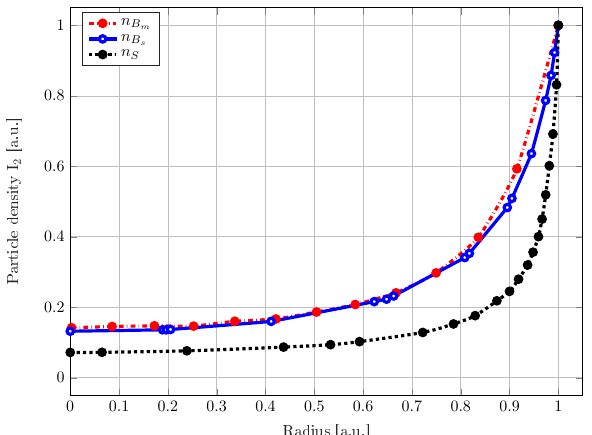
Figure 4. I 2 -particle density distribution along the lamp radius in the middle of the vessel. Com- parison of the measurements of Barnes et al. [11], indicated with n B parameters and geometry, indicated with n B presented in this paper, indicated as n s